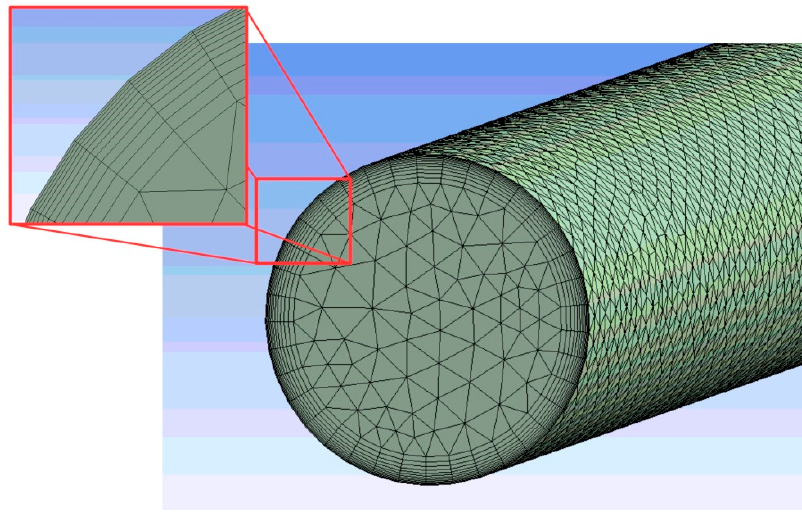
Figure 1. A view of a section of the mesh formed at a pipe diameter of 35 mm and a speed of 5 m/s.